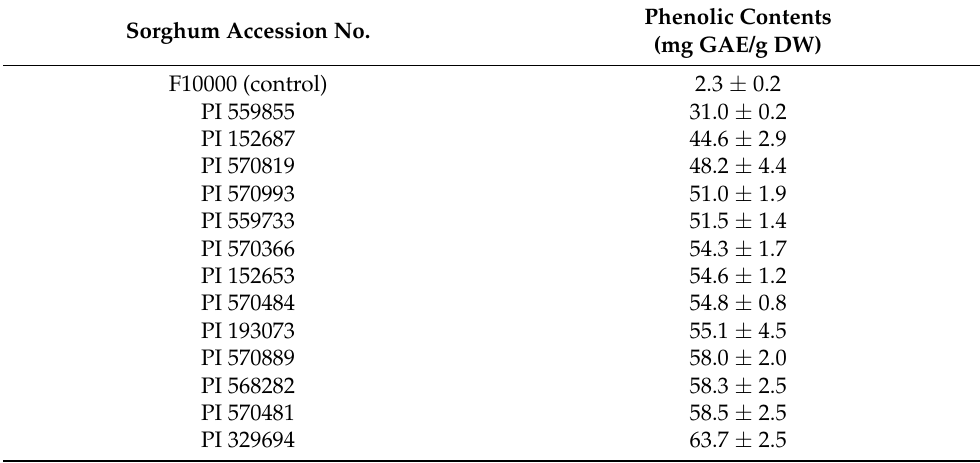
Table 1. Phenolic Contents in Various Specialty Sorghum Accessions (mean ± SD, n = 3). Sorghum Accession